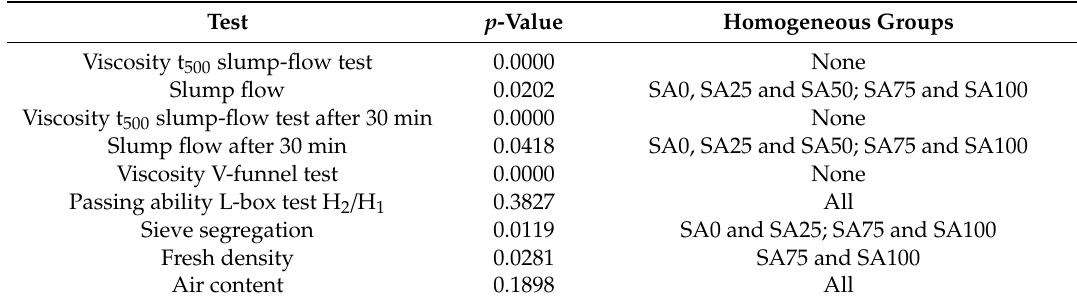
Table 6. One-factor ANOVA of the fresh